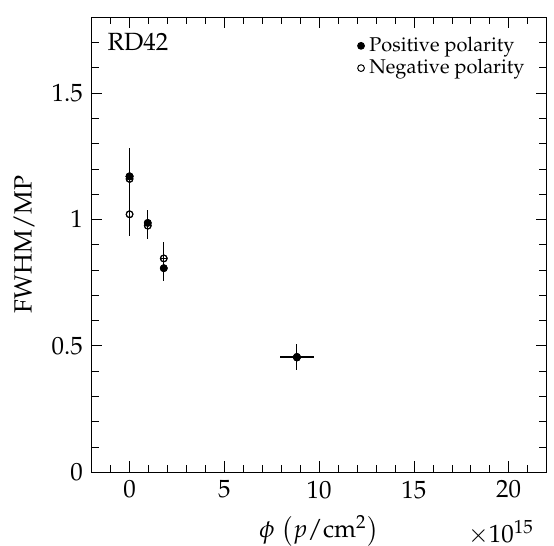
Figure 12. The FWHM/MP as a function of fluence in the 70MeV proton irradiation measured in a + 120GeV/ c hadron beam at CERN. The two values shown at each fluence are the values for positive (solid markers) and negative bias (open markers) at E = 2V/µm.